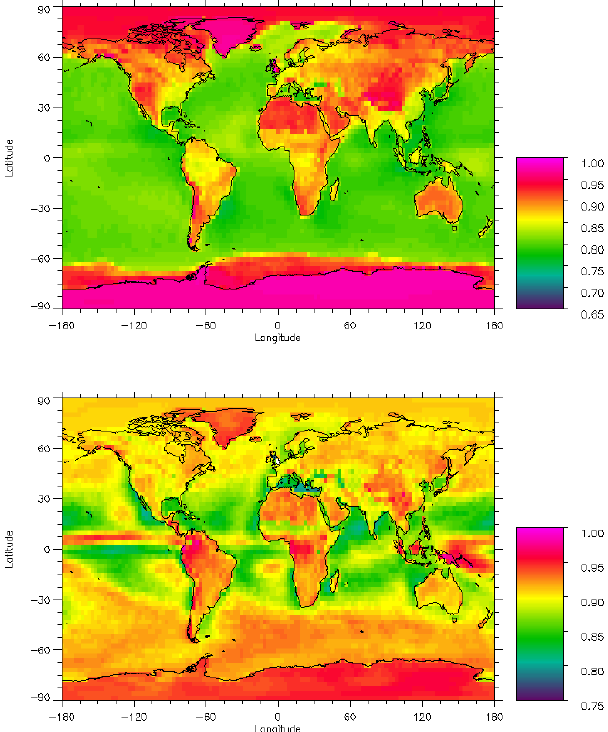
Figure 1. Geographical distribution of ratio between annual mean RF of BC from two-stream simulation relative to eight-stream sim- ulation for clear sky (upper) and all sky